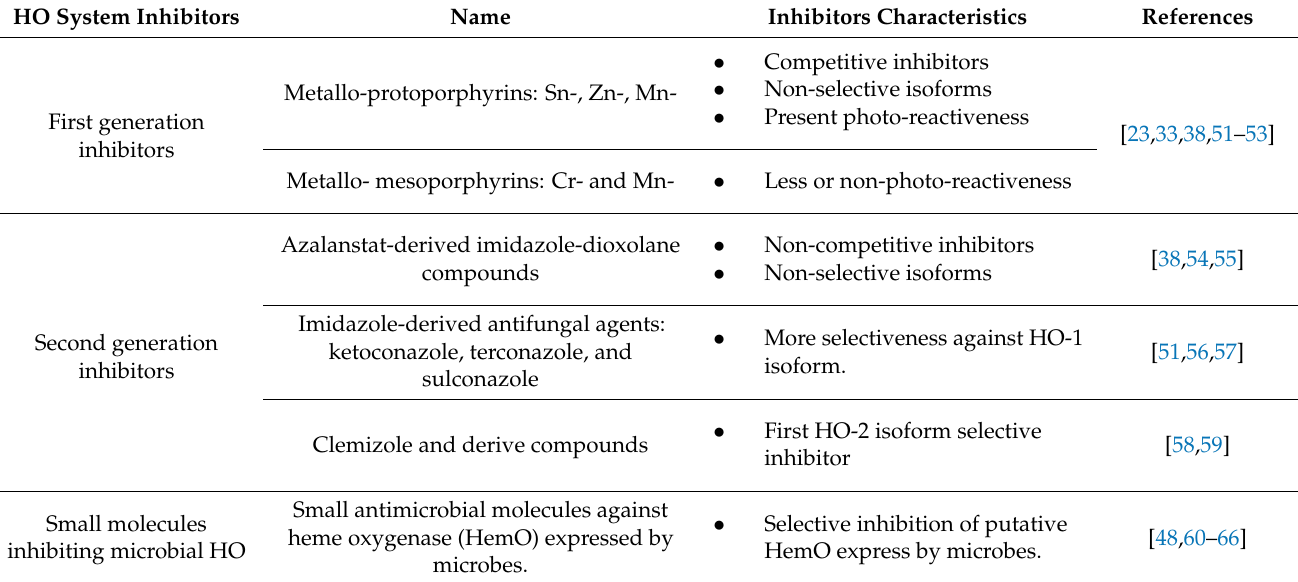
Table 1. Inhibitors of the HO system. General description of first-, second-generation, and novel HO inhibitors. HO System